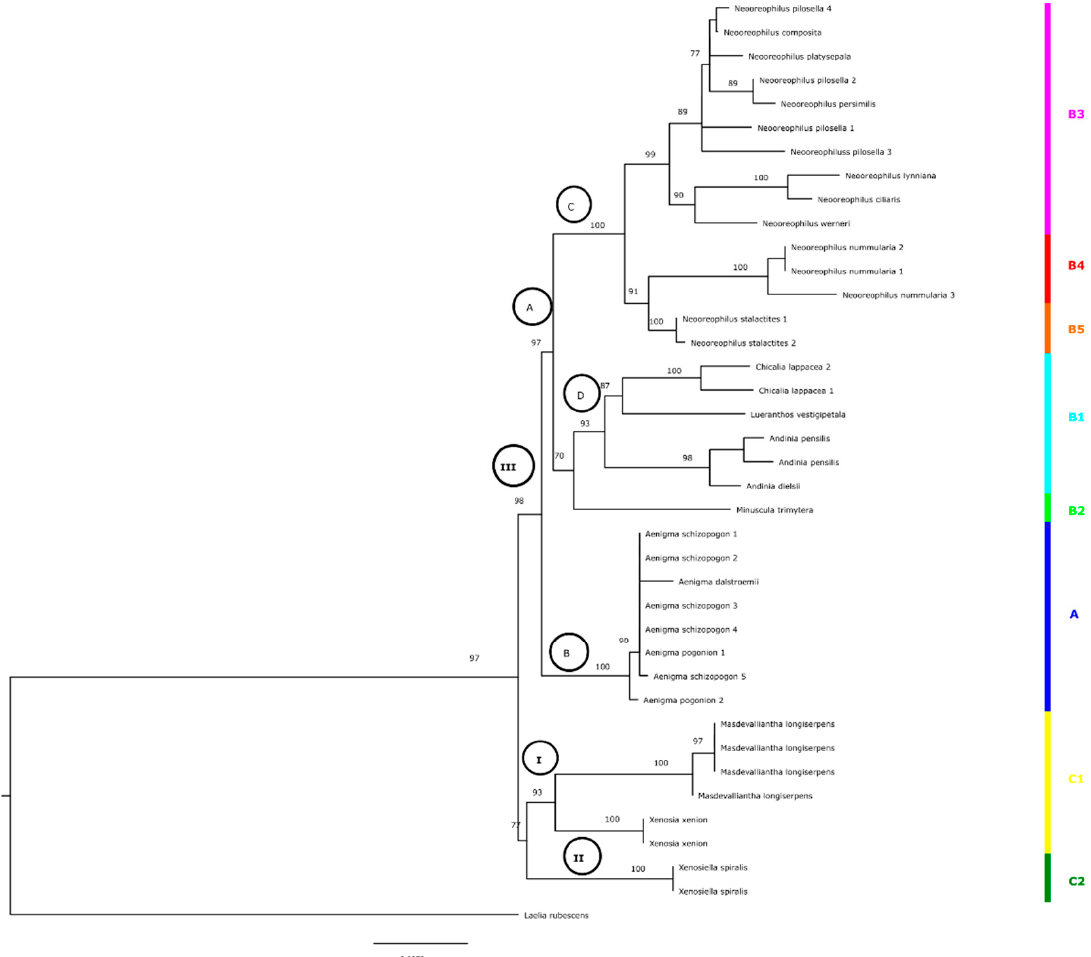
Figure 7. Phylogenetic tree performed based on maximum likelihood analysis inferred from the combined ITS- mat K dataset using ML/Transfer bootstrap expectation with 1000 bootstrap replicates in RaxML. Values at each node represent percent bootstrap support; bootstrap percentages less than 50% are not shown. The main and strong supported clades on the tree are marked with the numbers I–III. However, the subclades are tagged as capitals A–D. Discussed groups of species are marked as A–C2.